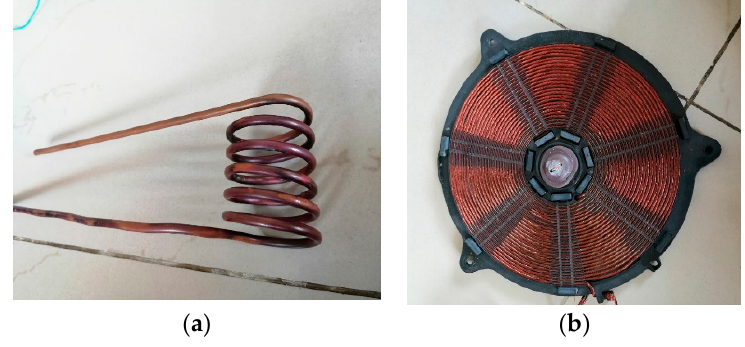
Figure 16. Working coils for ( a ) heating rods ( b ) heating flat vessels.